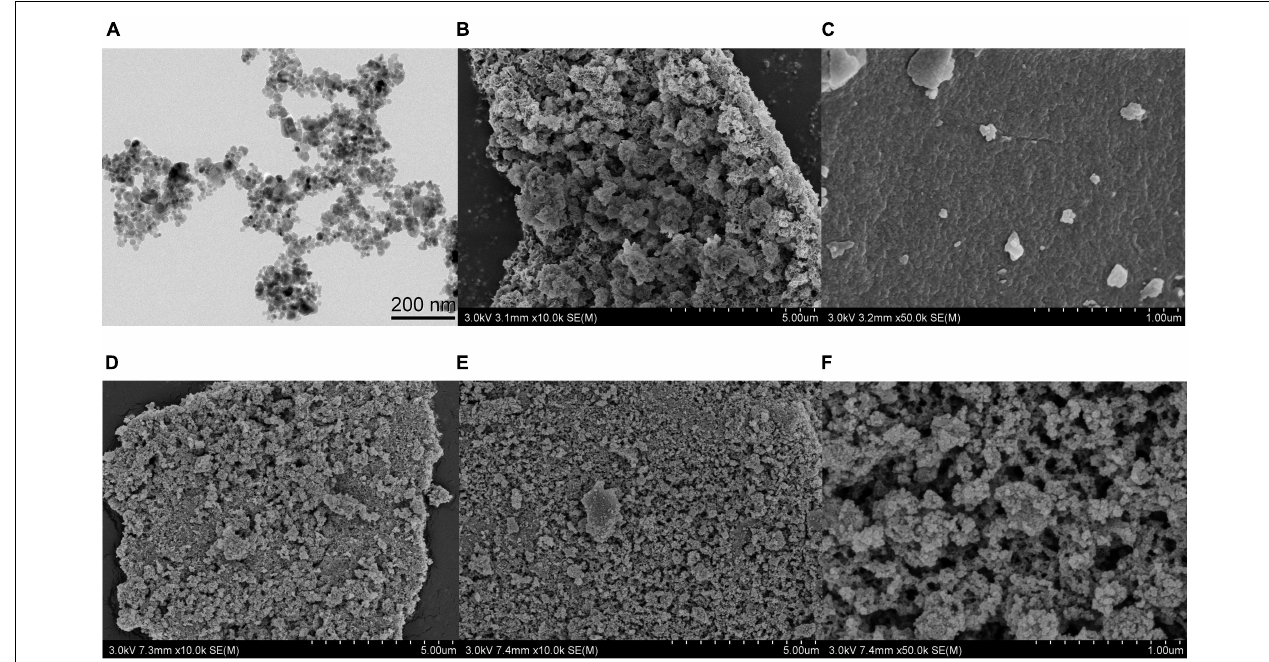
FIGURE 2 | (A) TEM image of Fe 3 O 4 . SEM images of (B) Zn-Al-LDH, (C) B-D-MIL-100, (D) Fe 3 O 4 @Zn-Al-LDH, (E,F) Fe 3 O 4